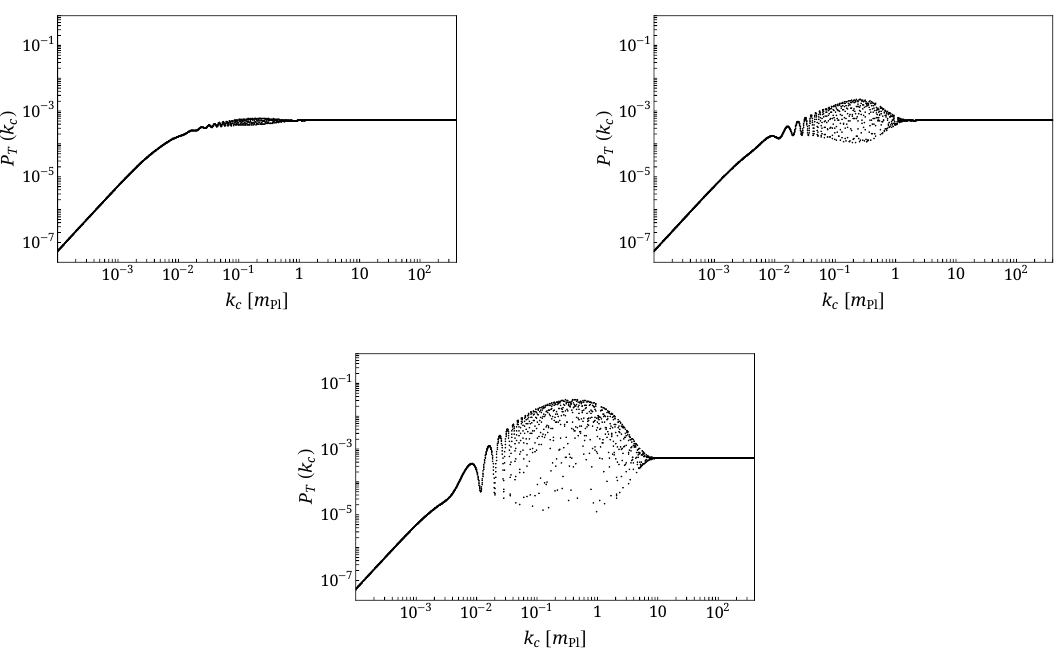
Figure 11. Primordial tensor spectra for different values of the bounce amplitude C , the other parameters being unchanged with respect to the reference case. ( First panel ) C = 0.1, ( Second panel ) C = 1 (reference case), and ( Third panel ) C = 10.